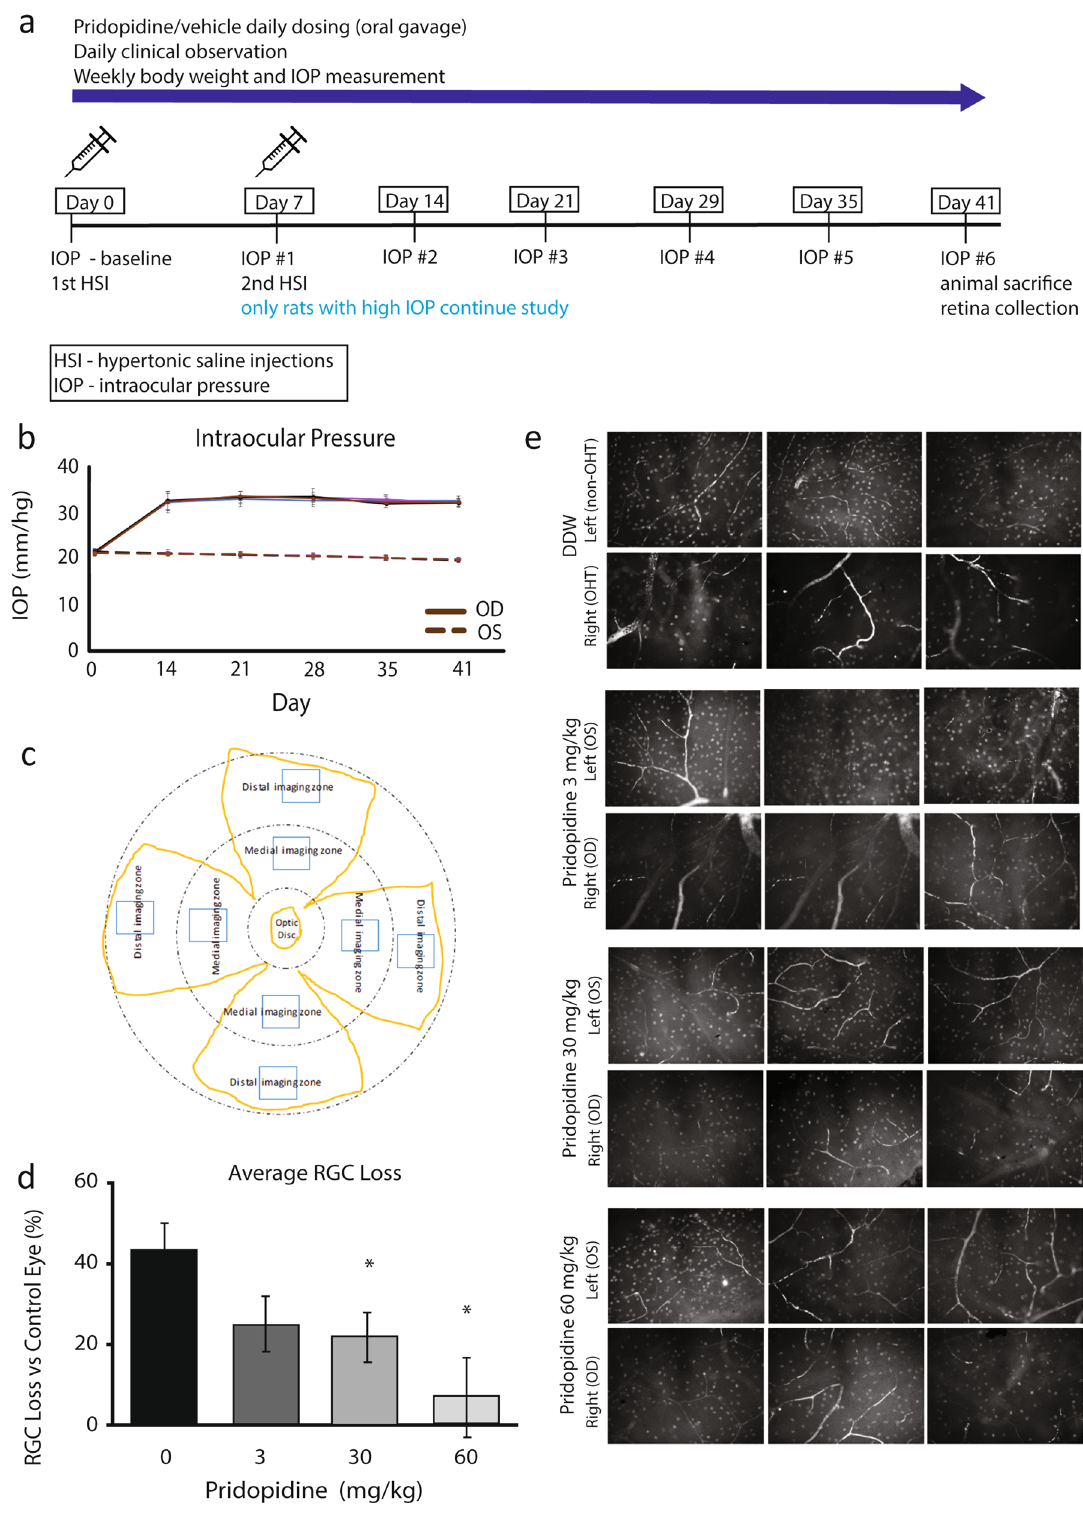
Figure 1. Pridopidine rescues RGCs at high doses in Morrison model for retinal neurodegeneration. ( a ) Diagram of study design. ( b ) Average IOP measured in OHT eye (OD) and non-OHT control (OS, dashed line) eye over 41 days of the study. ( c ) Diagram of regions of interest (ROI) collected from flat-mount retinas. Yellow outline—flat-mounted retina; Blue box—representative image location. ( d ) Average RGC loss per treatment group, calculated as the difference between the OD and the OS eye. ( e ) Representative images of retinas from treated rats stained for RGCs. Data is mean ± SEM. (n:DDW = 11, 3 mg/kg = 8, 30 mg/kg = 9, 60 mg/kg = 10; 4–8 images analyzed per eye). P < 0.05, One-way